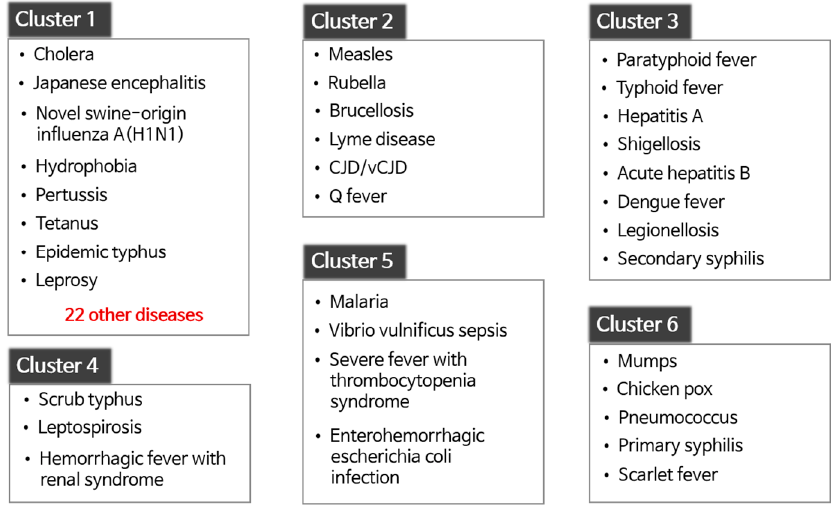
Figure 6. Infectious diseases in each disease cluster.